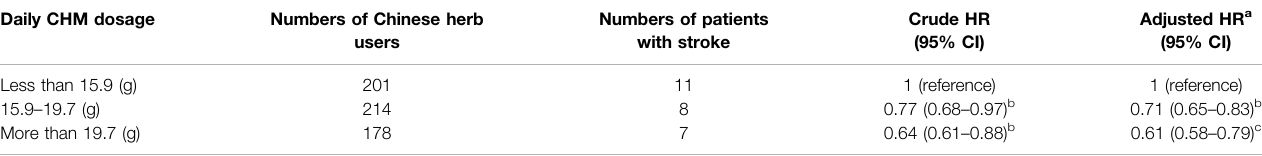
Abbreviations: CHM, Chinese herbal medicine; CI, con fi dence interval. a The model was adjusted by gender, age, index year, cancer-related therapy and stroke-related comorbidities, aspirin use, coagulopathy and disseminated intravascular coagulopathy. b p < 0.05. c p <